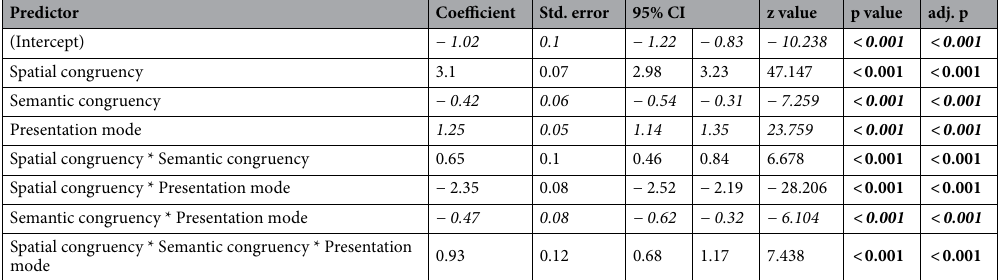
Table 1. Summary of the GLMM fitted for Sound localization accuracy in Experiment 1 (unmasked pictures). The results pertaining to our hypotheses are shown in roman, the remaining results in italics. Bold indicates significant p-values.